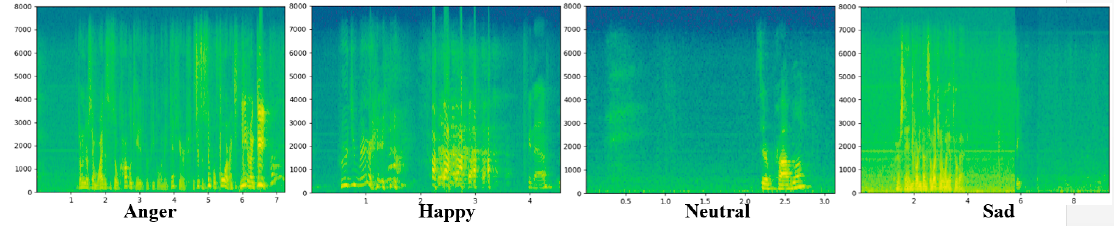
Figure 2. Spectrograms samples of different emotional speech signals.